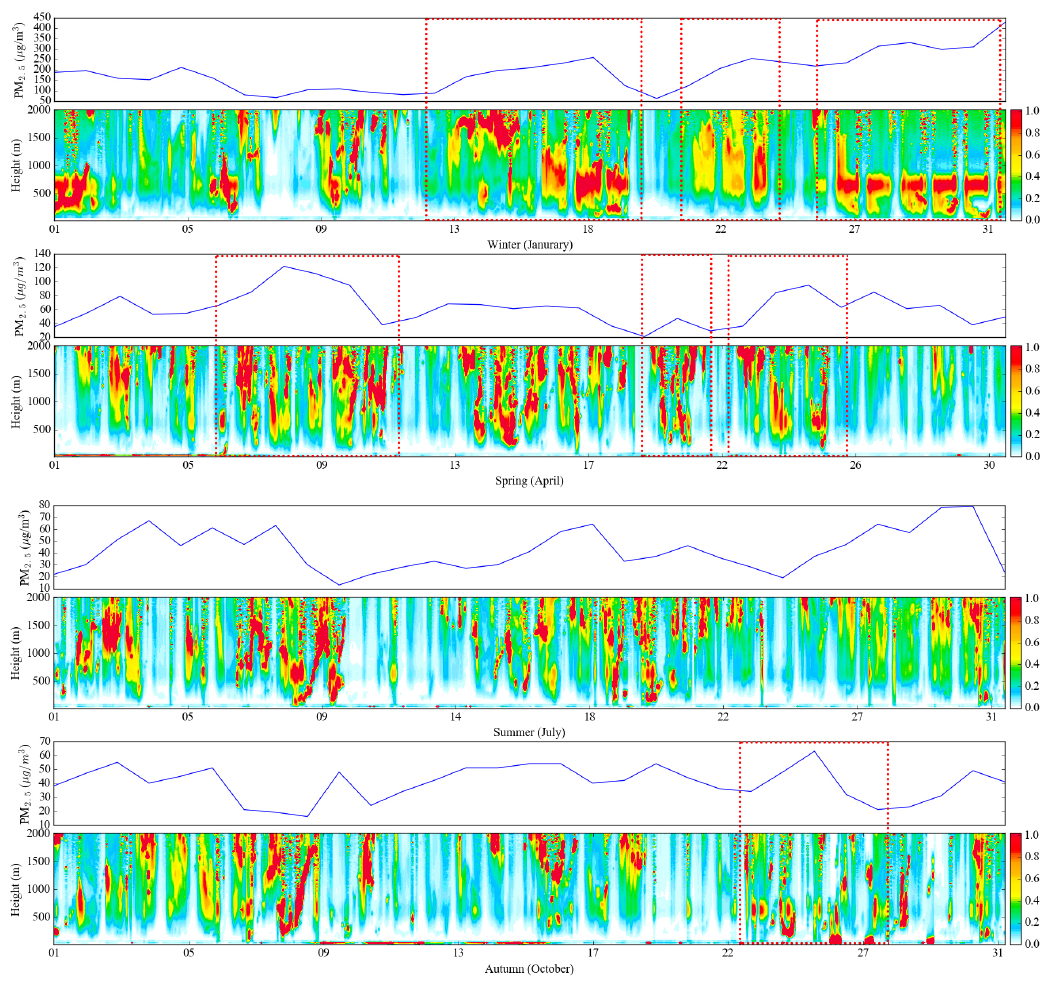
Figure 6. The time series variation of ground-based measured PM 2.5 concentrations and vertical profiles of particle extinction over the Sichuan Basin in